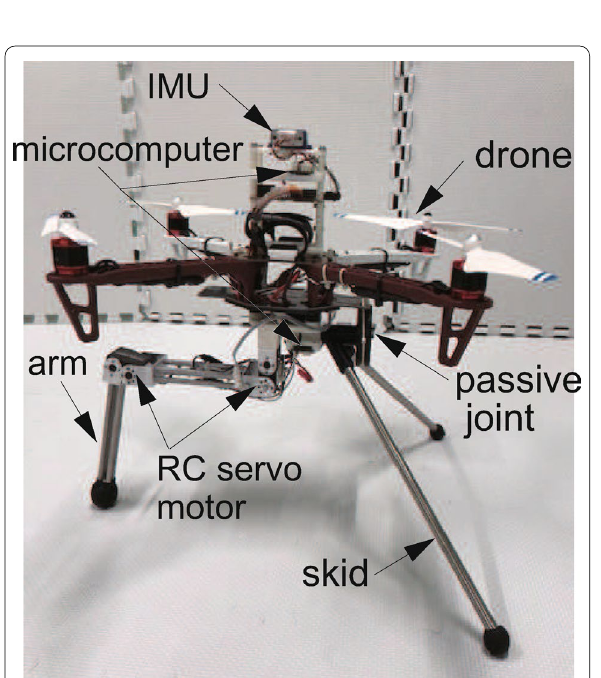
Fig. 12 The proposed device prototype